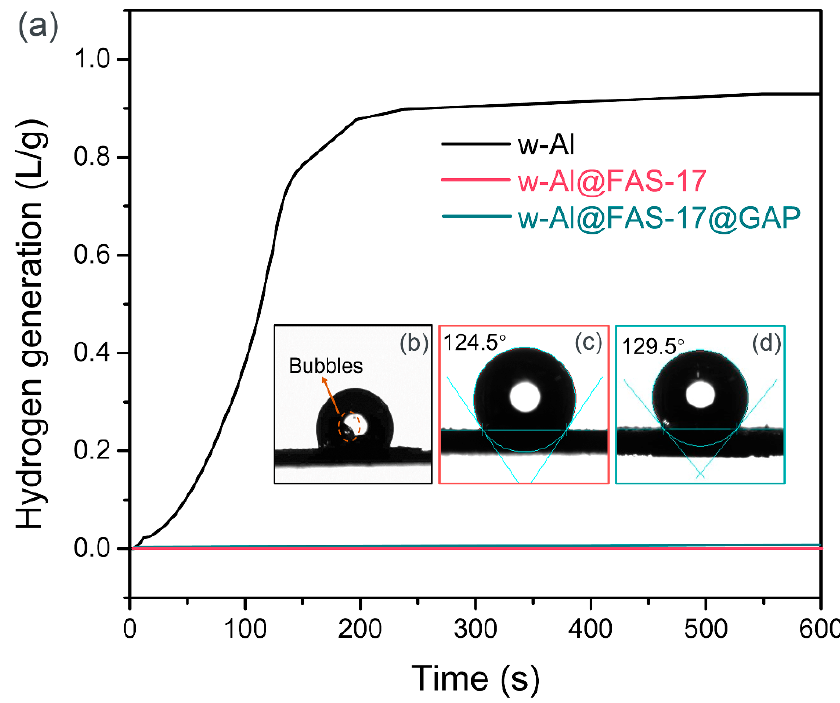
Figure 7. Hydrogen generation curves of w-Al, w-Al@FAS-17 and w-Al@FAS-17@GAP in H 2 O ( a ), photographs of static water contact angle of w-Al ( b ), w-Al@FAS-17 ( c ) and w-Al@FAS-17@GAP ( d ).